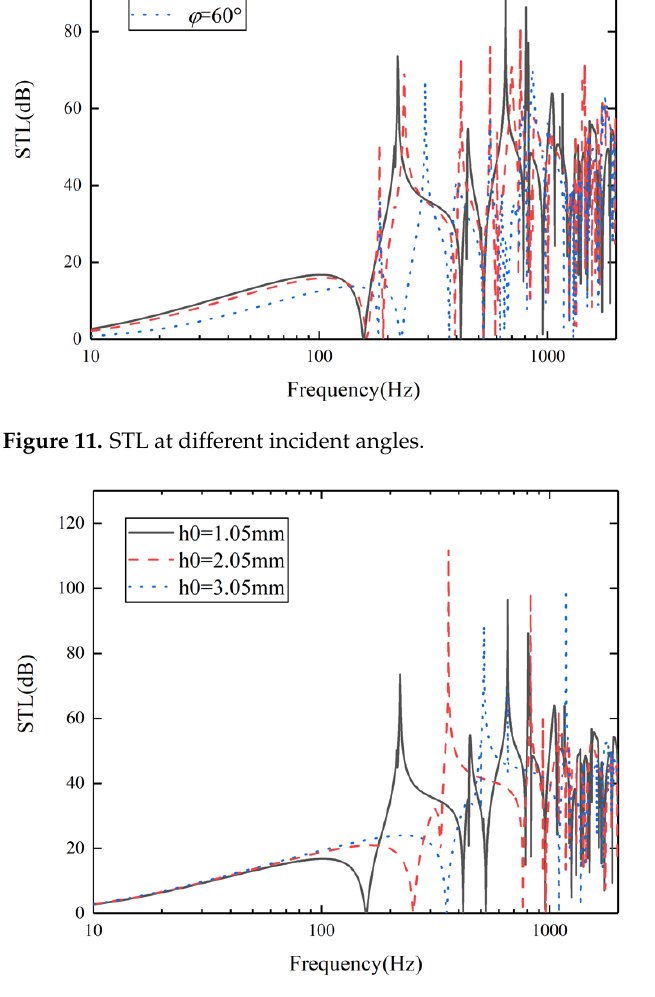
Figure 11. STL at different incident angles.